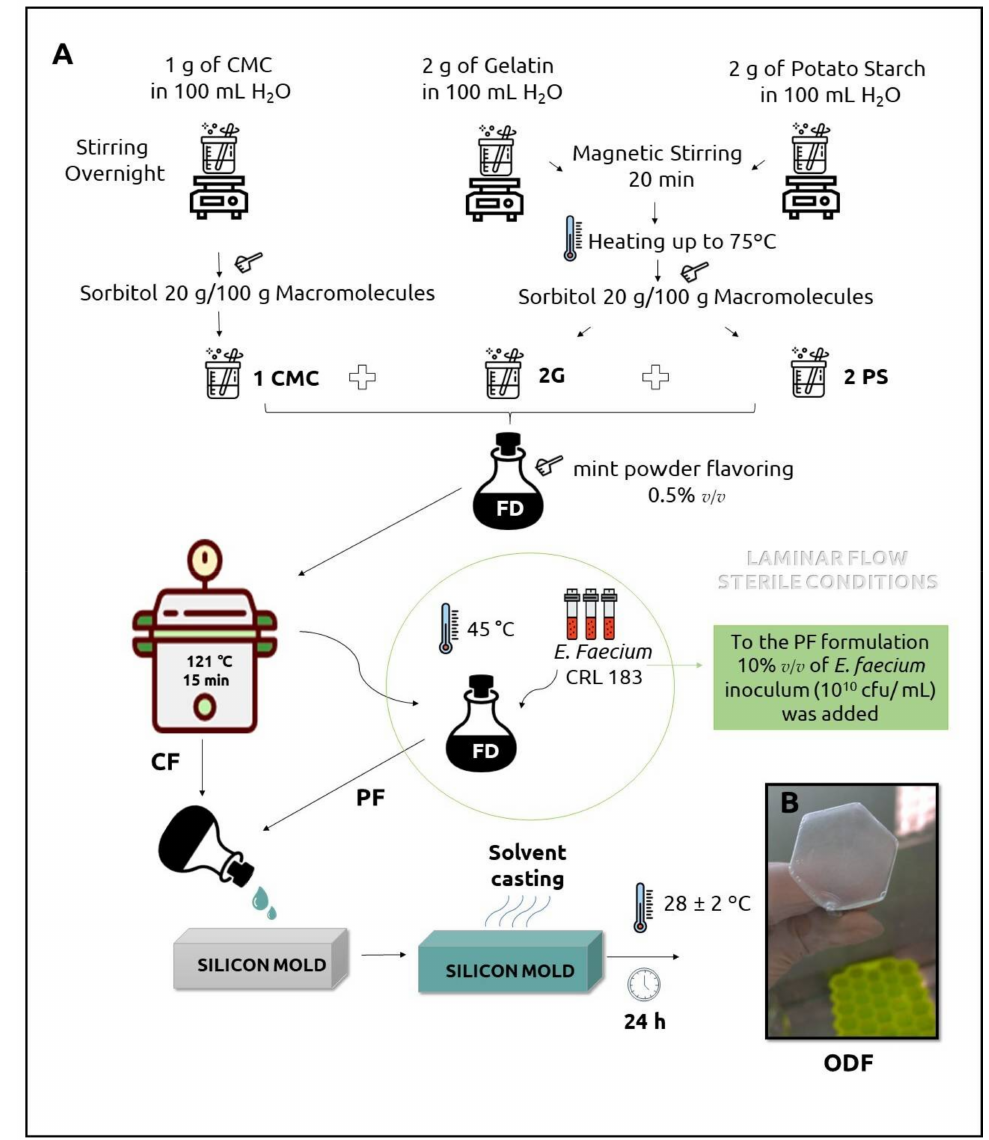
Figure 1. Orodispersible films preparation protocol ( A ). Orodispersible film ( B